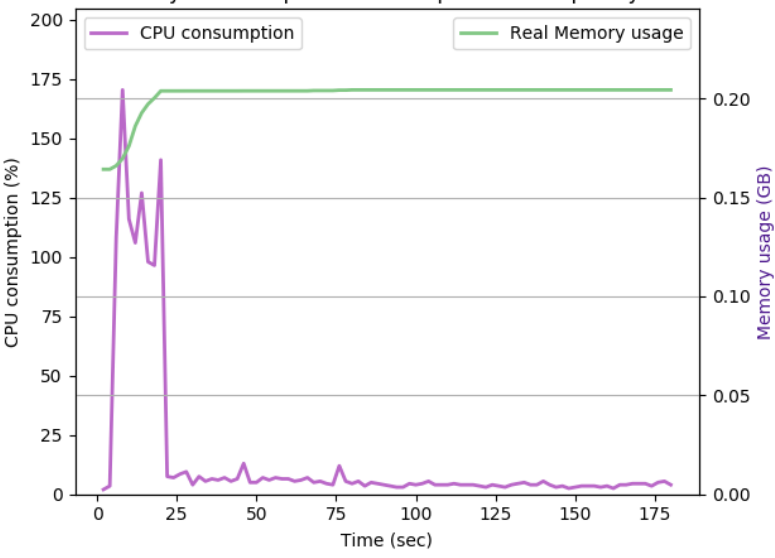
Figure 14. The CPU and memory utilization of the Raspberry Pi device using